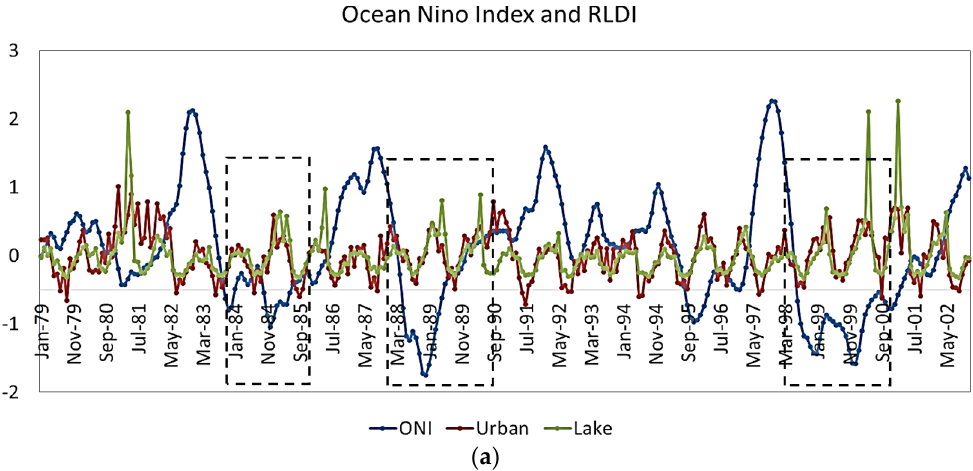
Figure 14. Cont. Figure 14. Cont.